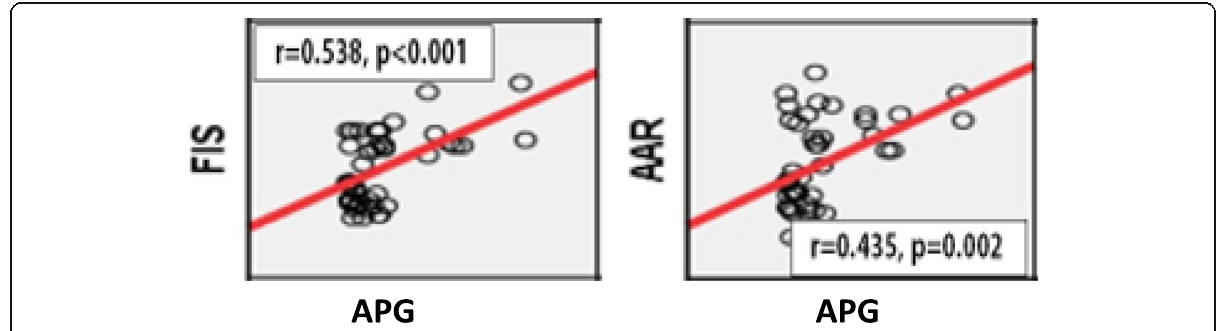
Fig. 2 Correlation between admission blood glucose and final infraction size (FIS) and area at risk